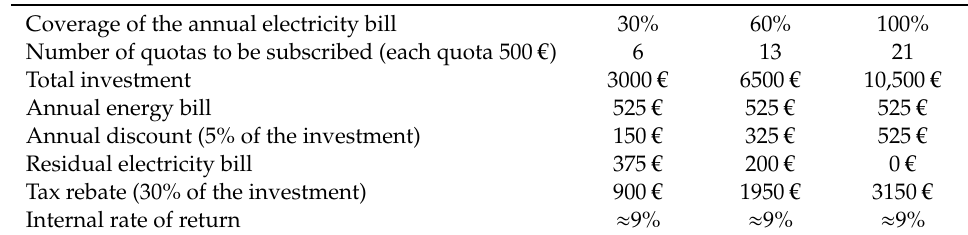
Table 7. Energia Positiva possible total investment and benefits for an annual consumption of 2700 kWh (electricity bill 525 € /